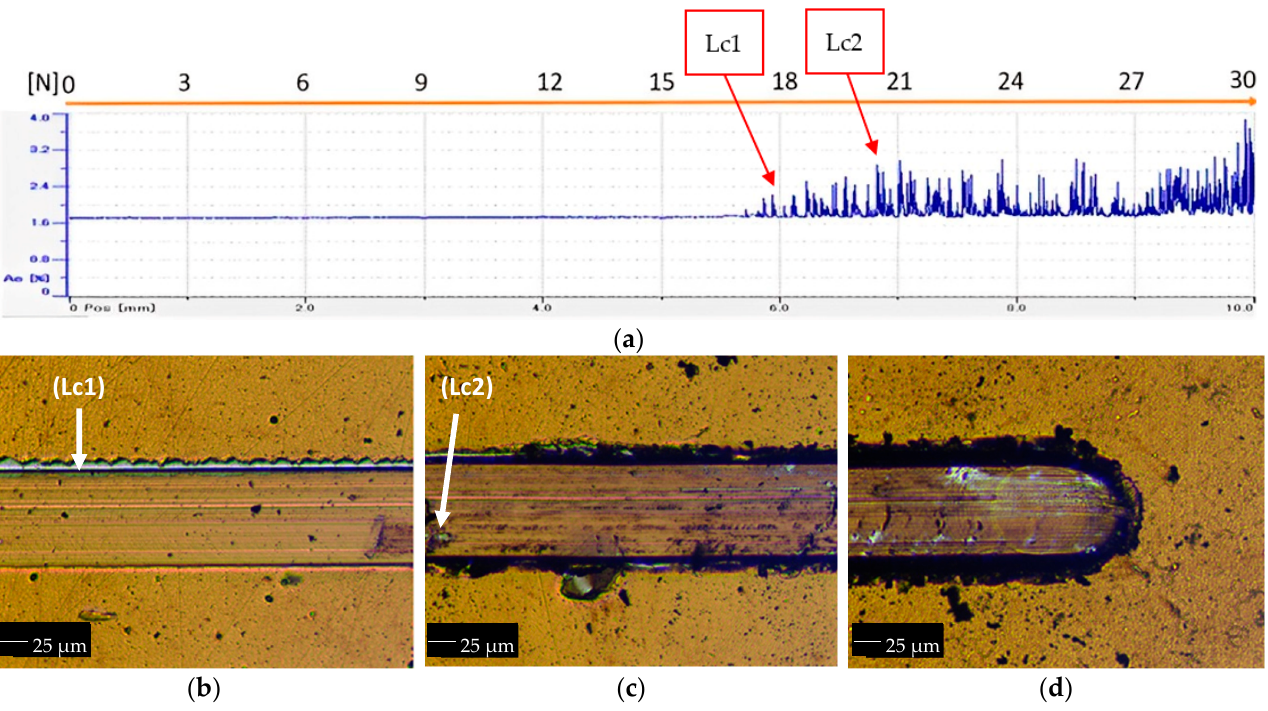
Figure 6. Scratch test progressive load (0–30 N) of TiN film: ( a ) acoustic emission signal as a function of scratch distance, ( b ) cohesive failure by lateral delamination (Lc1), ( c ) adhesive failures by the first exposure of the substrate (Lc2), and ( d ) area of the scratch end.